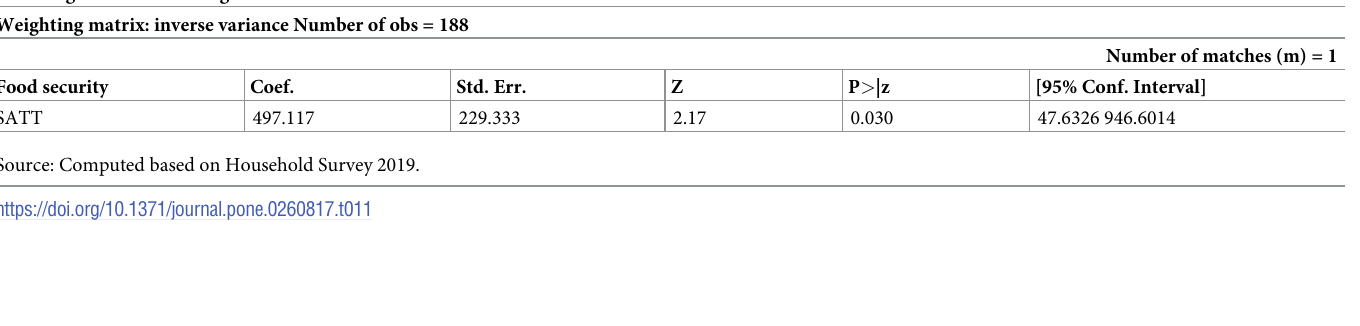
Table 11. Average treatment effect for the treated-on food security. Matching estimator: Average Treatment Effect for the Treated Weighting matrix: inverse variance Number of obs = 188